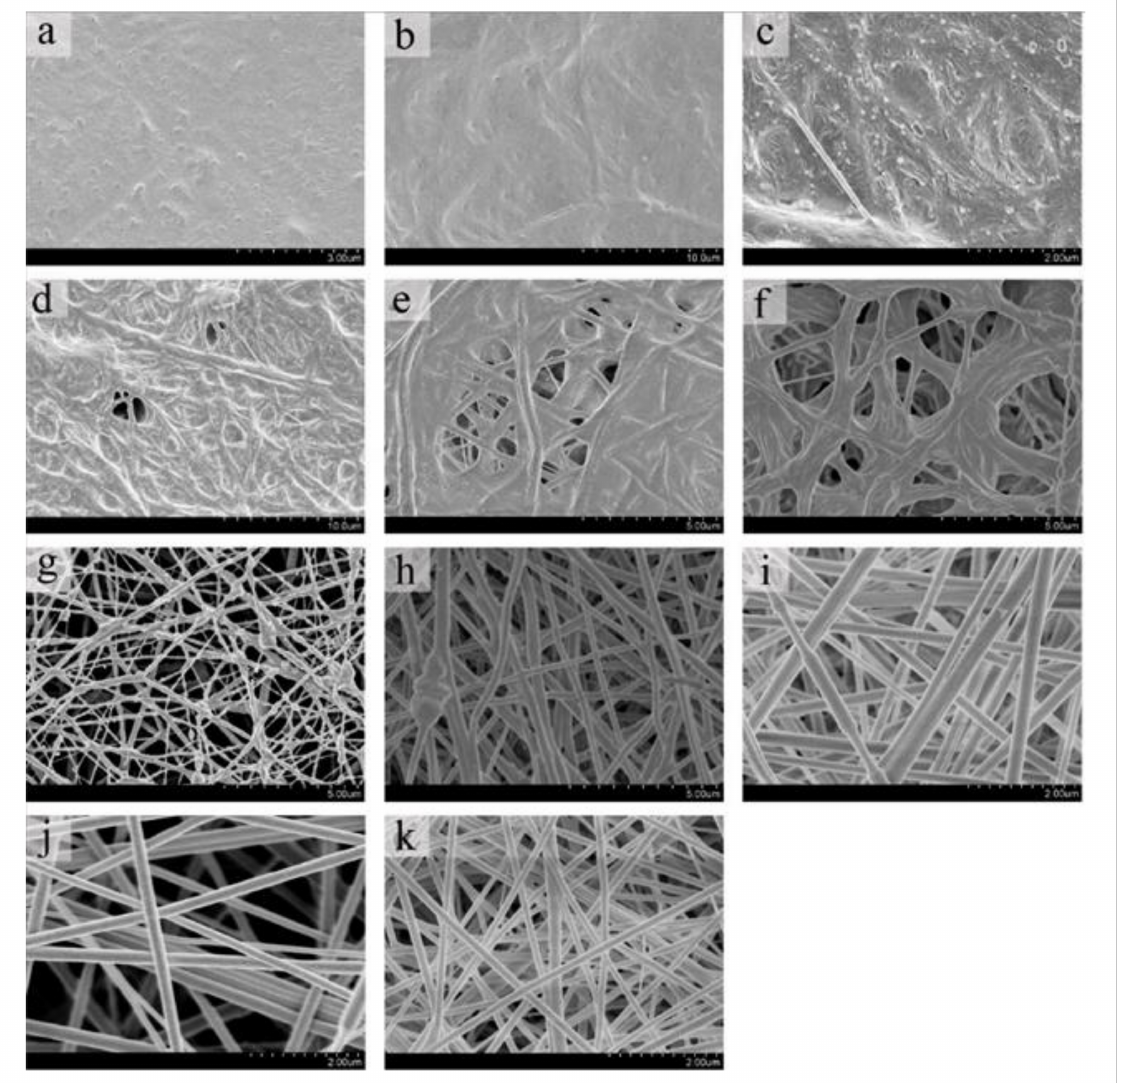
Figure 1. SEM results of FC-PCL nanofiber membrane. Figures ( a – k ) is the electrospinning results with m (FC): m (PCL) = 0: 10, 1:9, 2:8, 3:7, 4:6, 5:5, 6:4, 7:3, 8:2, 9:1, 10:0. The fiber diameter was analyzed by SDM and Origin software (Figure 2). With the increase of collagen content, the average fiber diameter became smaller, but an exception occurred when m (FC): m (PCL) was 6:4. In this case, the state of the solution might be unstable and there was adhesion between the fibers, resulting in the formation of very fine fibers. Therefore, the fiber diameter changed greatly and the average fiber diameter decreased. Figure 2 showed that the higher the proportion of collagen, the more uniform the fiber diameter distribution. When m (FC): m (PCL) was 10:0, the diameter was mainly distributed between 100–150 nm. When m (FC): m (PCL) was 9:1, the diameter was mainly distributed between 150–250 nm. With the decrease in collagen ratio, the fiber diameter distribution gradually